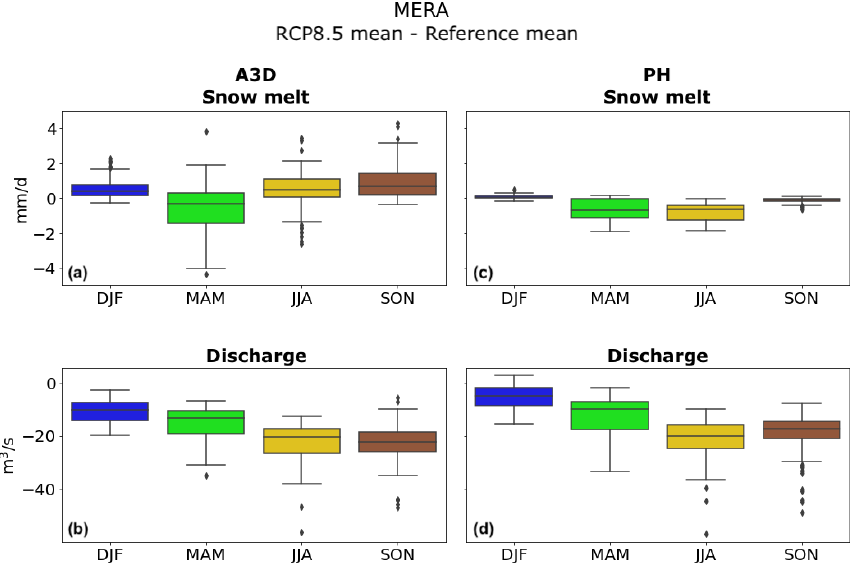
Figure 11. Boxplot illustrating the difference between the 2080–2090 RCP8.5 scenario mean and the reference mean (1990–2000) for snowmelt (a) and discharge (b) predicted by A3D (a, b) and PH (c, d) for the Mera catchment.